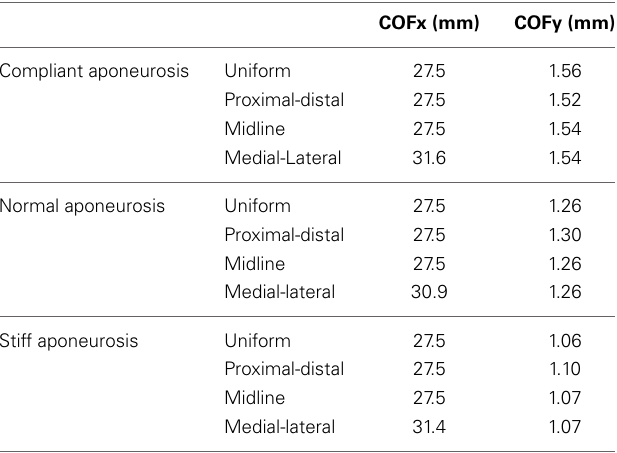
Table 2 | x and y components of the center of Force (COF) on the z = 0